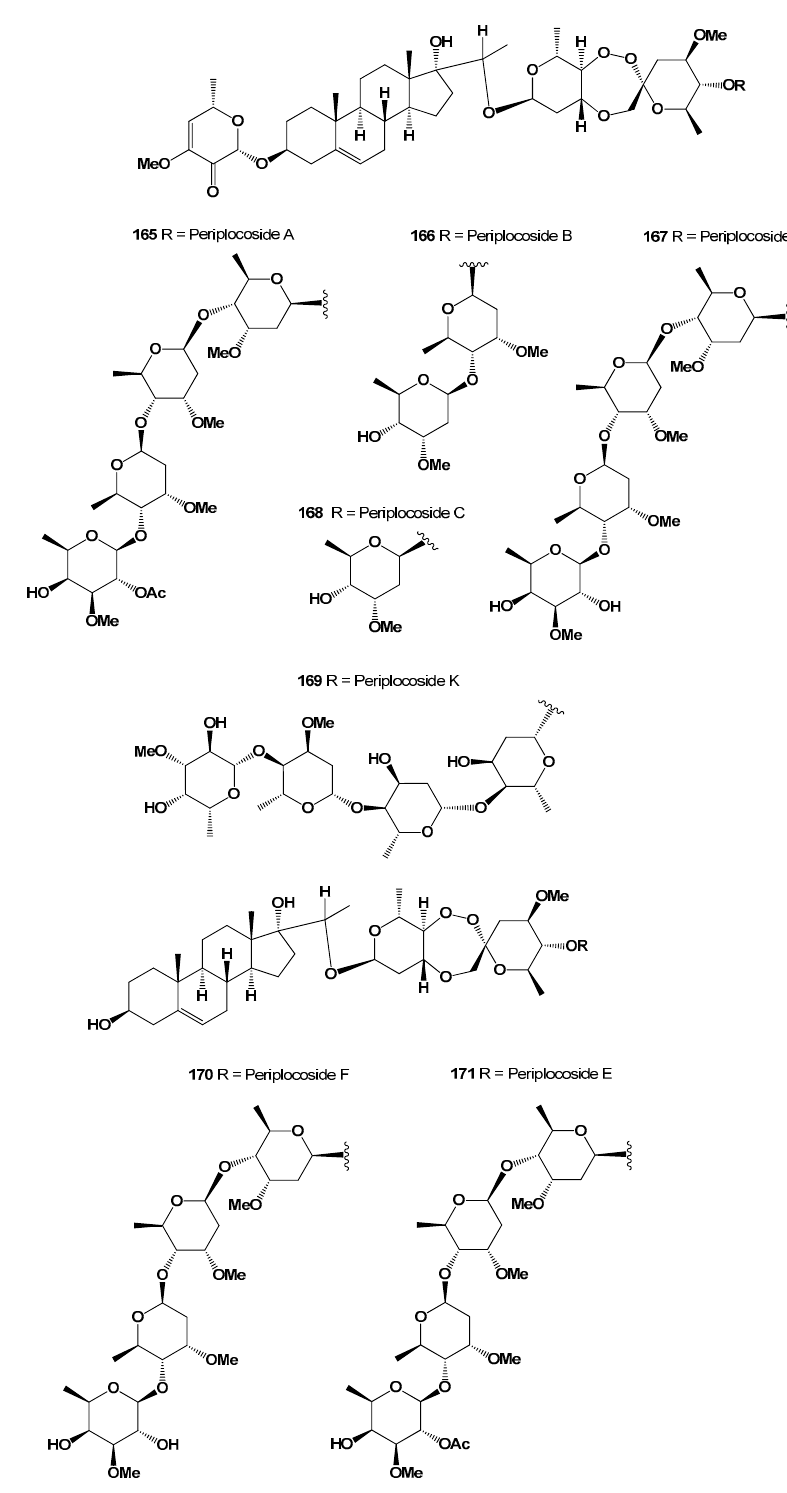
Figure 11. Bioactive steroidal glycosides derived from plants.